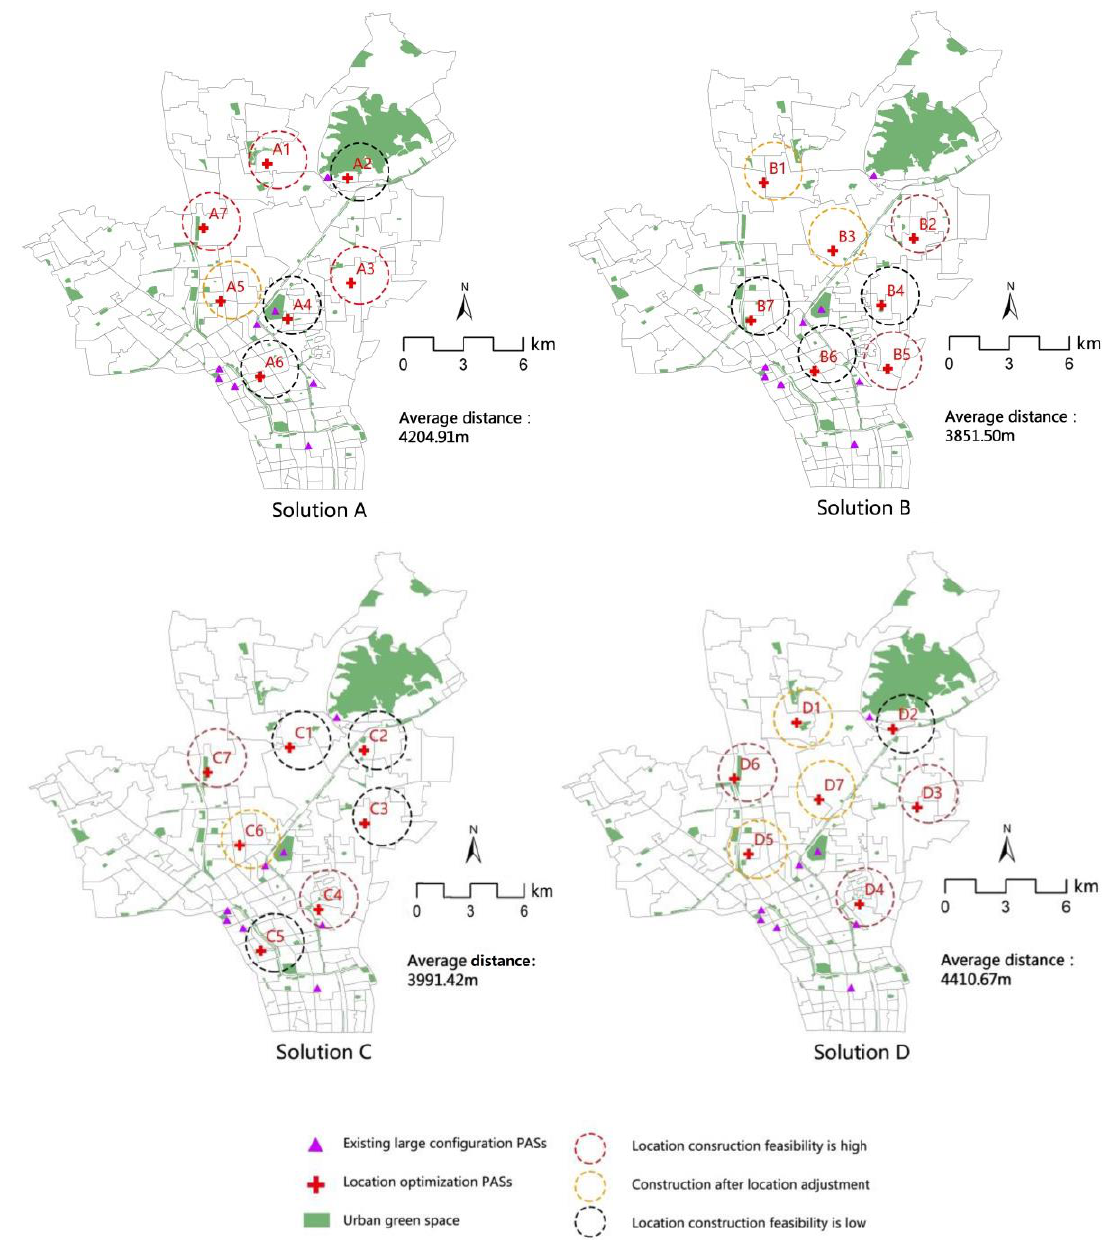
Figure 6. The PAS’ locations of the four